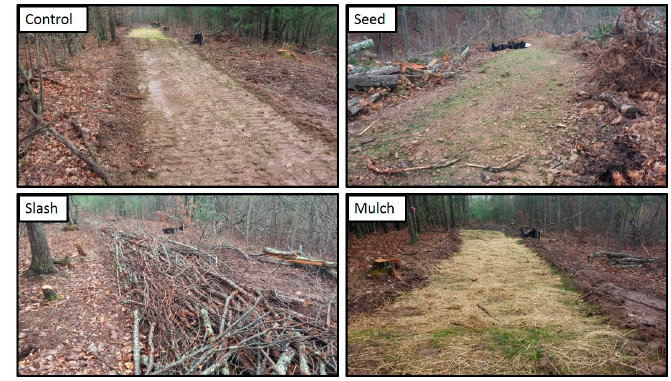
Figure 3. A comparison of the four skid trail closeout best management practices (BMPs) used in the study.